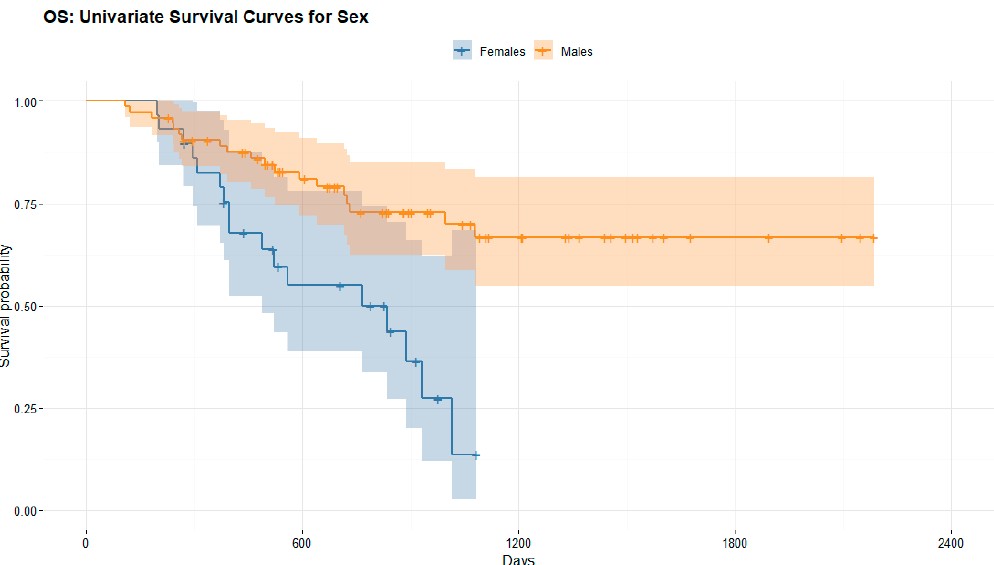
Figure 8. Kaplan–Meier survival curve stratified by overall survival OS (in days) in men (orange) and women (blue) with advanced melanoma treated with immunotherapy. The female curve ends earlier than the male curve due to a shorter follow-up time (mean 620 days vs. 880 days for men), as displayed in Figure 7.